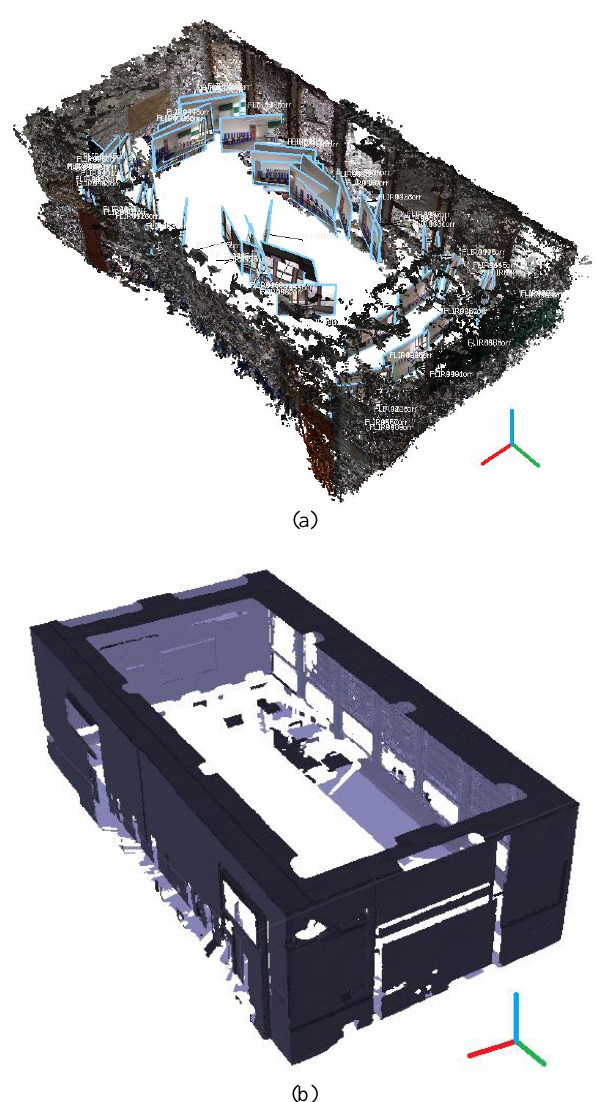
Figure 5. Data processing in Metashape software: (a) RGB images orientation and generated dense point cloud; (b) mesh created based on laser scanning point